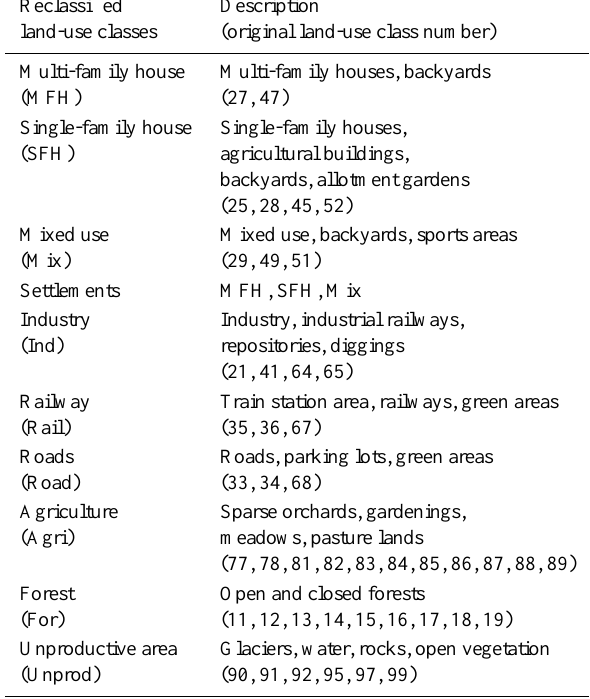
Table 1. Reclassification of the land-use classes by BFS (2011). The abbreviations will be used further on in the document. To simplify, MFH, SFH, and Mix will also be merged to settlements.